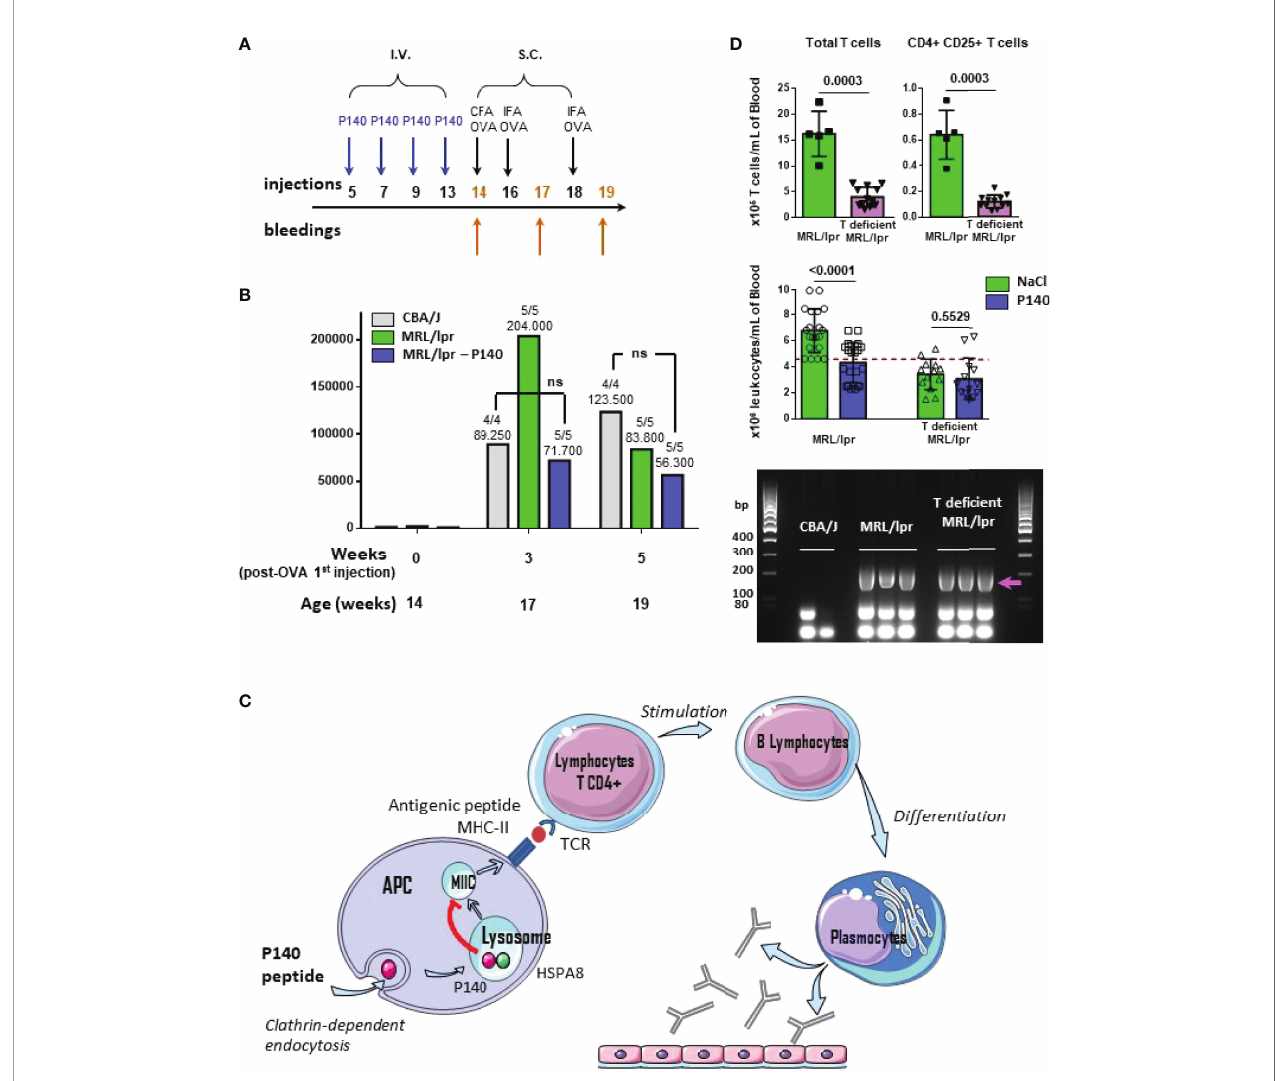
FIGURE 5 | P140 mechanism of action. (A, B) P140 does not affect the ability of treated mice to mount an ef fi cient response elicited by a foreign model immunogen. (A) Protocol of injections and bleedings used in this experiment. (B) The sera collected from CBA/J, untreated and P140-treated MRL/lpr mice that received ovalbumin (OVA) as model foreign immunogen, were tested by ELISA for their capacity to produced anti-OVA IgG antibodies. The trend shown here was con fi rmed in two independent experiments that altogether involved a total of 15 mice/study group (one of two independent experiments is shown). The titers were de fi ned as the reciprocal of the dilution giving an absorbance value of 0.5. The average titer and the number of responder animal (titer>250) are indicated at the top of each histogram. P values measured using Mann-Whitney test. ns, non-signi fi cant. (C) Schematic representation of the domino mechanism of action of P140. (D) Characteristics of 13 week-old T-de fi cient MRL/lpr mice and comparative effect of P140 in 13-week old T-de fi cient and WT MRL/lpr mice. Top: number of total peripheral T cells and activated CD4 + CD25 + cells per mL in 5 WT MRL/lpr and 12 T-de fi cient MRL/lpr mice; P values measured using Mann-Whitney test. Middle: number of white blood cells per mL, before and after P140 treatment (n = 20 and 13 in the group of WT MRL/lpr and T-de fi cient MRL/lpr mice, respectively); P values measured using unpaired t test. Bottom: genotyping of Fas as determined by PCR of genomic DNA from the tail of mice (n = 2-3 mice/group taken randomly). CBA/J mice were used a negative control. The arrow indicates the position of the band to detect Fas. Additional data are presented in the Supplementary Material